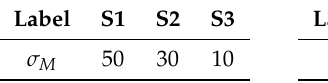
Table 3. Labels associated with algorithmic parameters